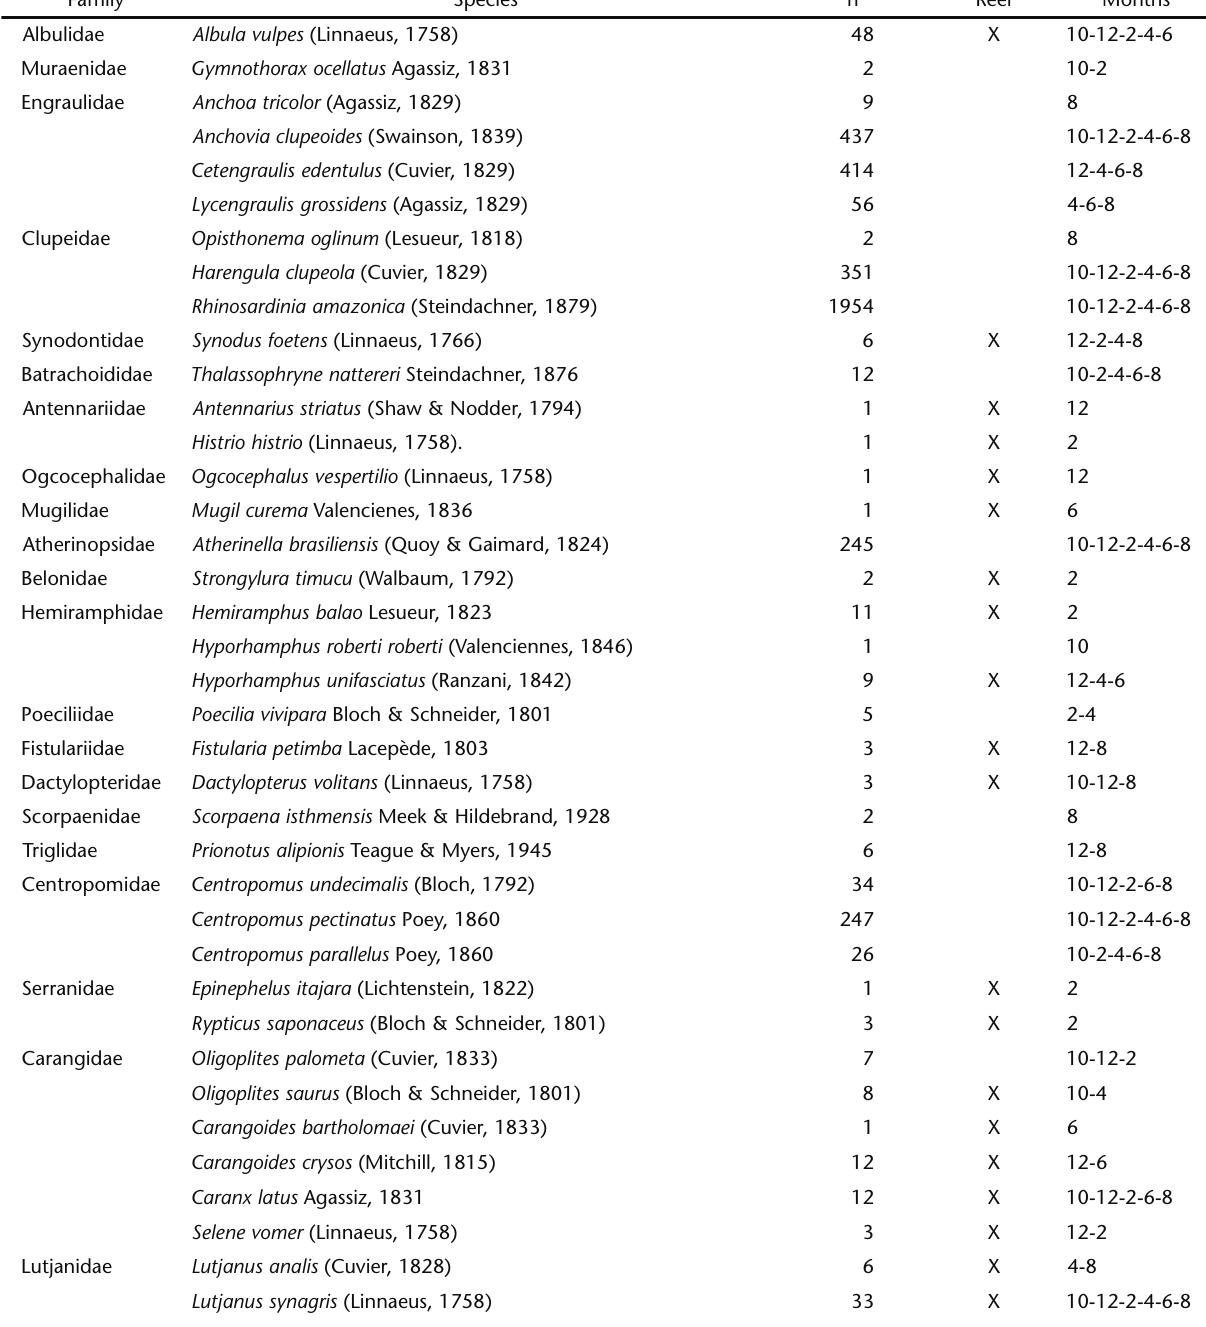
Table I. Families and species of the Rio Formoso estuary, with the number of individuals (n) and collection months indicated by numbers corresponding to the period between October, 2005 and August, 2006. Species classified as reef species are indicated with an X.